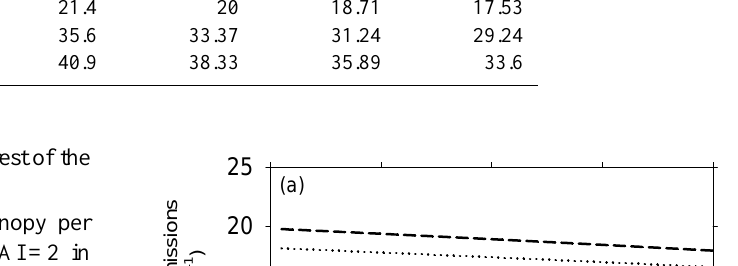
Table 1. Total daily canopy isoprene emissions for 1m 2 in clear atmosphere and dusty atmosphere with a range of reductions in temperature. LAI Clear atmosphere Dusty atmosphere T = 293 . 0K T = 293 . 0K T = 292 . 5K